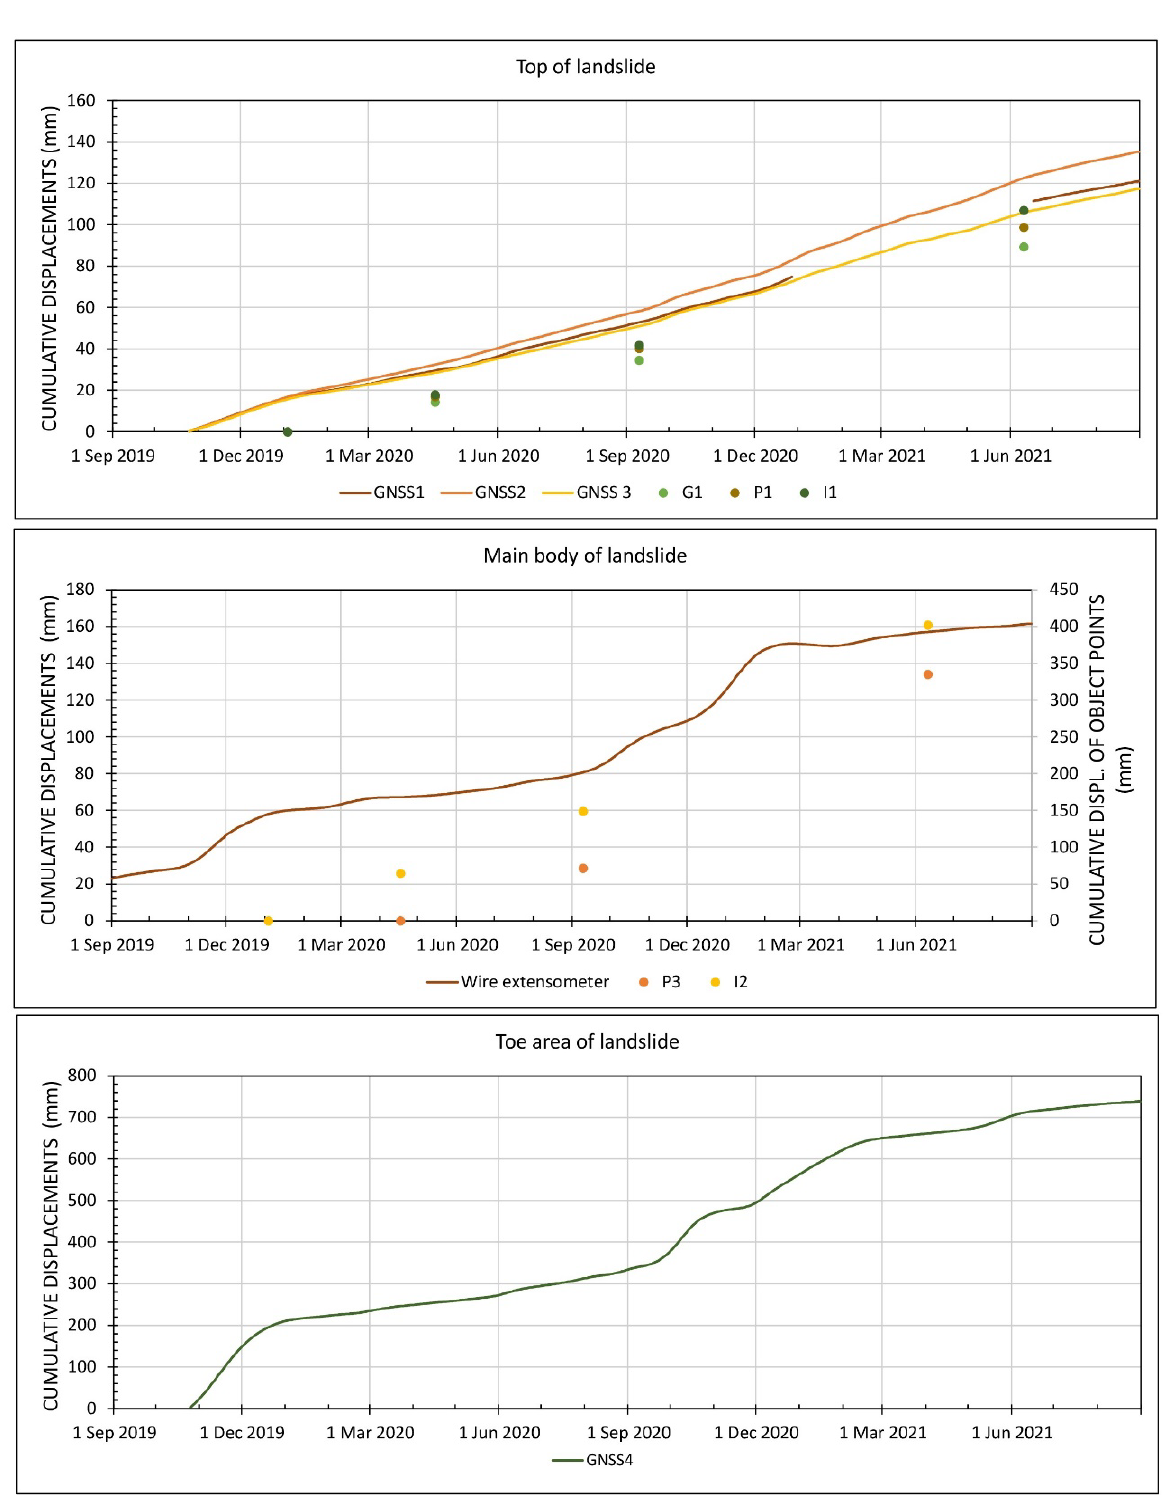
Figure 4. Landslide cumulative displacement curves obtained by GNSS1 (brown line), GNSS2 (orange line), GNSS3 (yellow line), GNSS4 (green line), and the wire extensometer (red line) compared to landslide periodic displacements from object points (G1, P1, P2, I1, and I2) for the 22-month period from 24 October 2019 to the 31 August 2021. During the period between 28 December 2020 and 16 June 2021, the GNSS1 (brown line) had a data outage, due to technical problems.